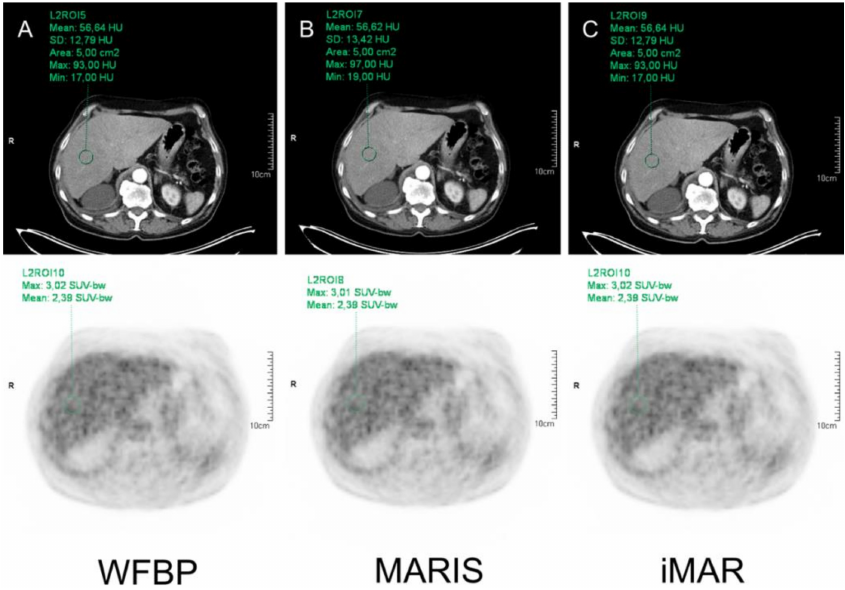
Figure 1. Example of HU and SUV measurement in the liver in WFBP ( A ), MARIS ( B ), and iMAR ( C ). Average Hounsfield Unit (HU) values in the CT images as well as SUVmean and SU- Vmax values in PET images were measured for each ROI. Measurements were conducted in the liver (segment 6), lung (right and left lower lobe, segment 6), descending aorta, thoracic vertebral body 12, autochthonous back muscles, pectoral muscles, and internal jugular vein (Figure 2). The respective ROI was placed outside of artifacts and in morphologically inconspicuous